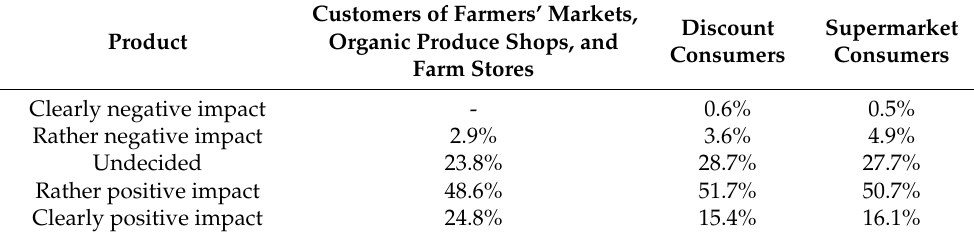
Table A4. Assessment of the effect of iodine on the human organism by place of purchase. ( n = 1016).